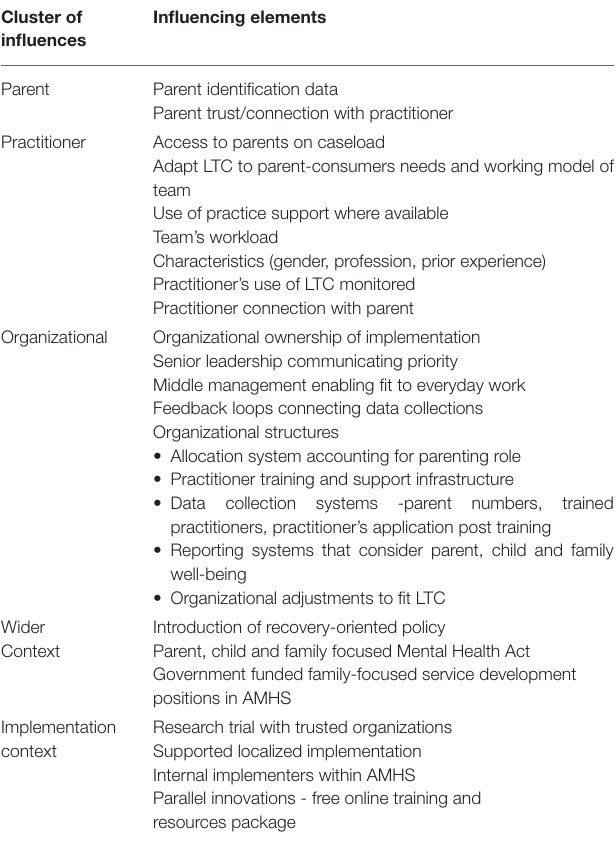
TABLE 1 | Key elements influencing sustainability of LTC. Cluster of Influencing influences